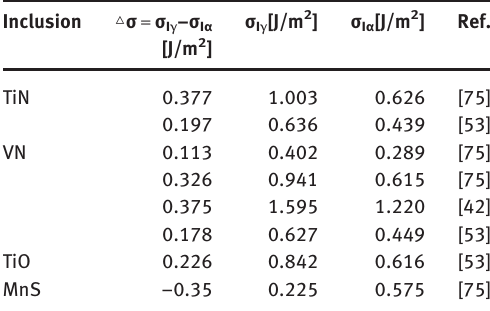
Table 2: Chemical part interfacial energies between the inclusions and austenite/ferrite interfaces, which are used for the calculations of IGF nucleation [10].